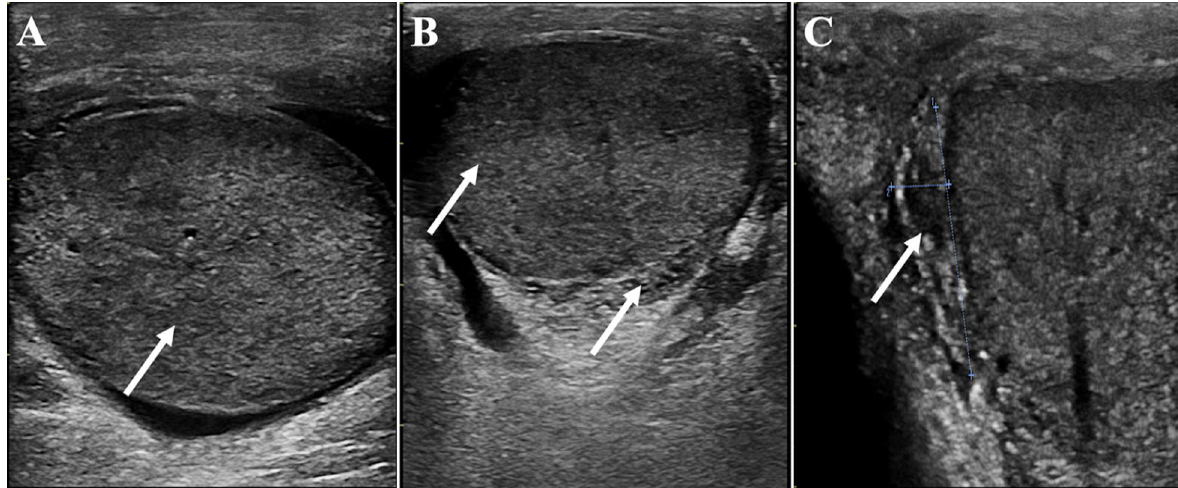
Fig. 2 Significant improvement of epididymitis in A, B, and C (arrows), only mild epididymitis seen in C (arrow). No pyocele or septations are observed. The organs are normal in echogenicity and homogeneous in